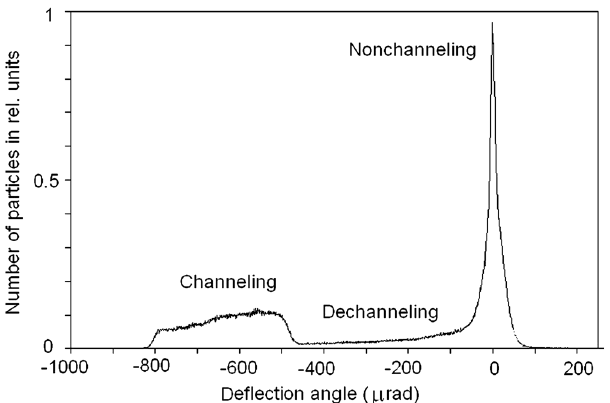
FIG. 5. The angular distribution of particles which passed through the focusing crystal. Three characteristic regions are visible: nonchanneling, channeling, and dechanneling. The histogram corresponds to the projection of the 2D distribution in Fig. 4 within the interval − 0 . 94 mm < x < 1 . 01 mm.